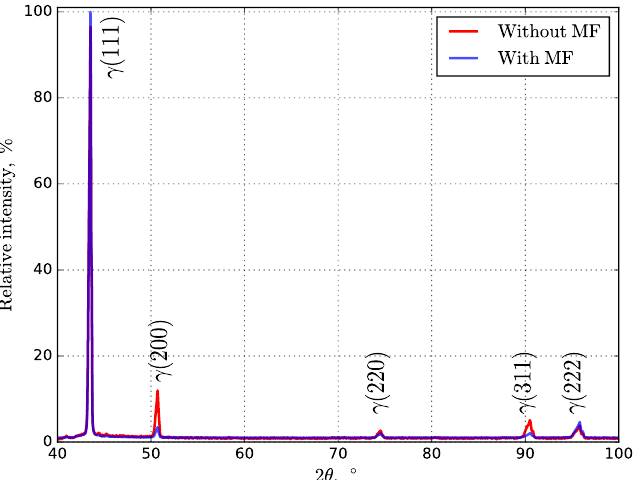
Figure 9. Normalized XRD patterns up to the maximum for investigated Inconel 718 samples printed under no and superimposed MF